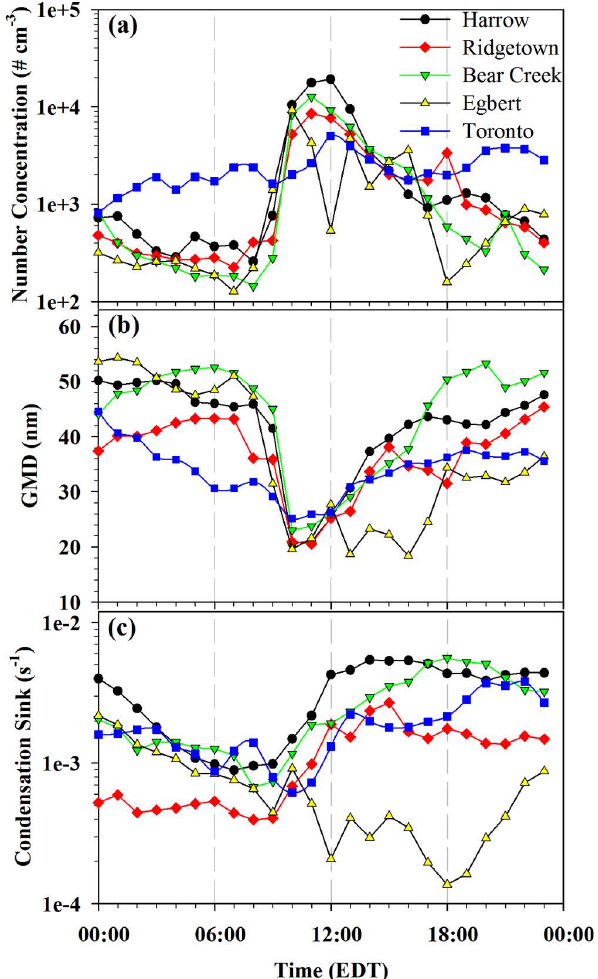
Fig. 9. Number concentrations of particles in the size range of 14nm–25nm (a) , geometric mean diameters of nucleated particles in the size range of 14nm–100nm (b) , and condensation sink (c) during the regional nucleation event observed on 2 July 2007.